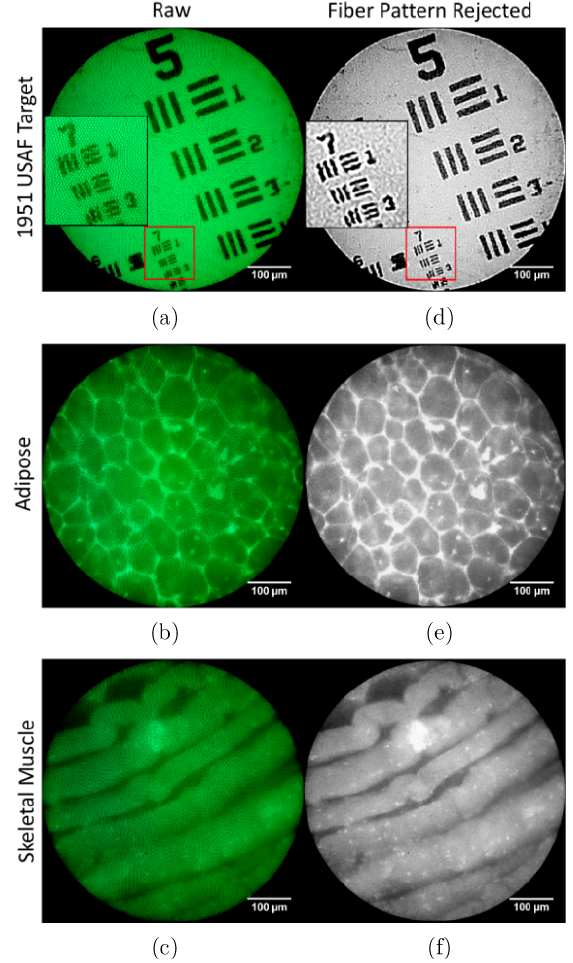
Fig. 3. Raw and ¯ber pattern rejected °uorescence images taken from a 1951 USAF resolution target (a), (d), an ex vivo porcine adipose tissue (b), (e) and ex vivo bovine skeletal muscles (c),